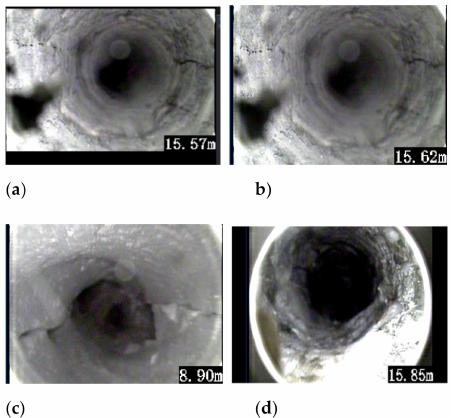
Figure 14. Image result diagram of speculum. ( a ) Drilling peep location: back footage 2380 m. ( b ) Drilling peep location: back footage 2387 m. ( c ) Drilling peep location: back footage 2490 m. ( d ) Drilling peep location: back footage 2680 m.